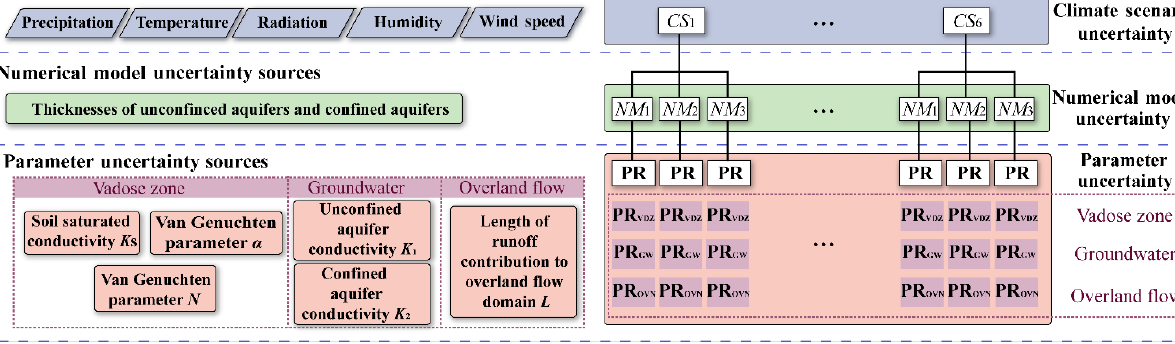
Figure 2. The framework of the hierarchical sensitivity analysis developed for PAWS and applied to the central Amazon basin. The three uncertainty source types are placed into the appropriate hierarchical level according to their dependence relationships. The left part of this figure shows the sources of these uncertainties, and the right side shows the abbreviations and the structural relationships among the various uncertainties. The number of climate scenarios (CSs) in this study is six; the number of plausible numerical models under each climate scenario is three; and the number of parameter sets under each numerical model is 600. Notably, the parameter uncertainty sources are further divided into three parts: vadose zone parameters, groundwater parameters, and the overland flow